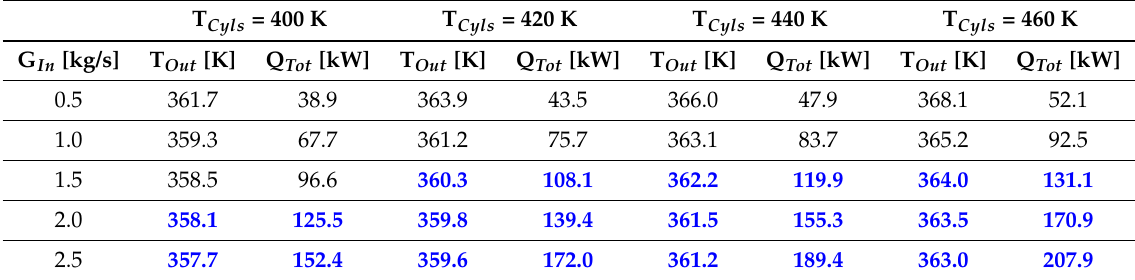
Table 6. Mass-averaged outflow temperature and total transferred heat flux tabulated as a function of G In and T Cyls for the new